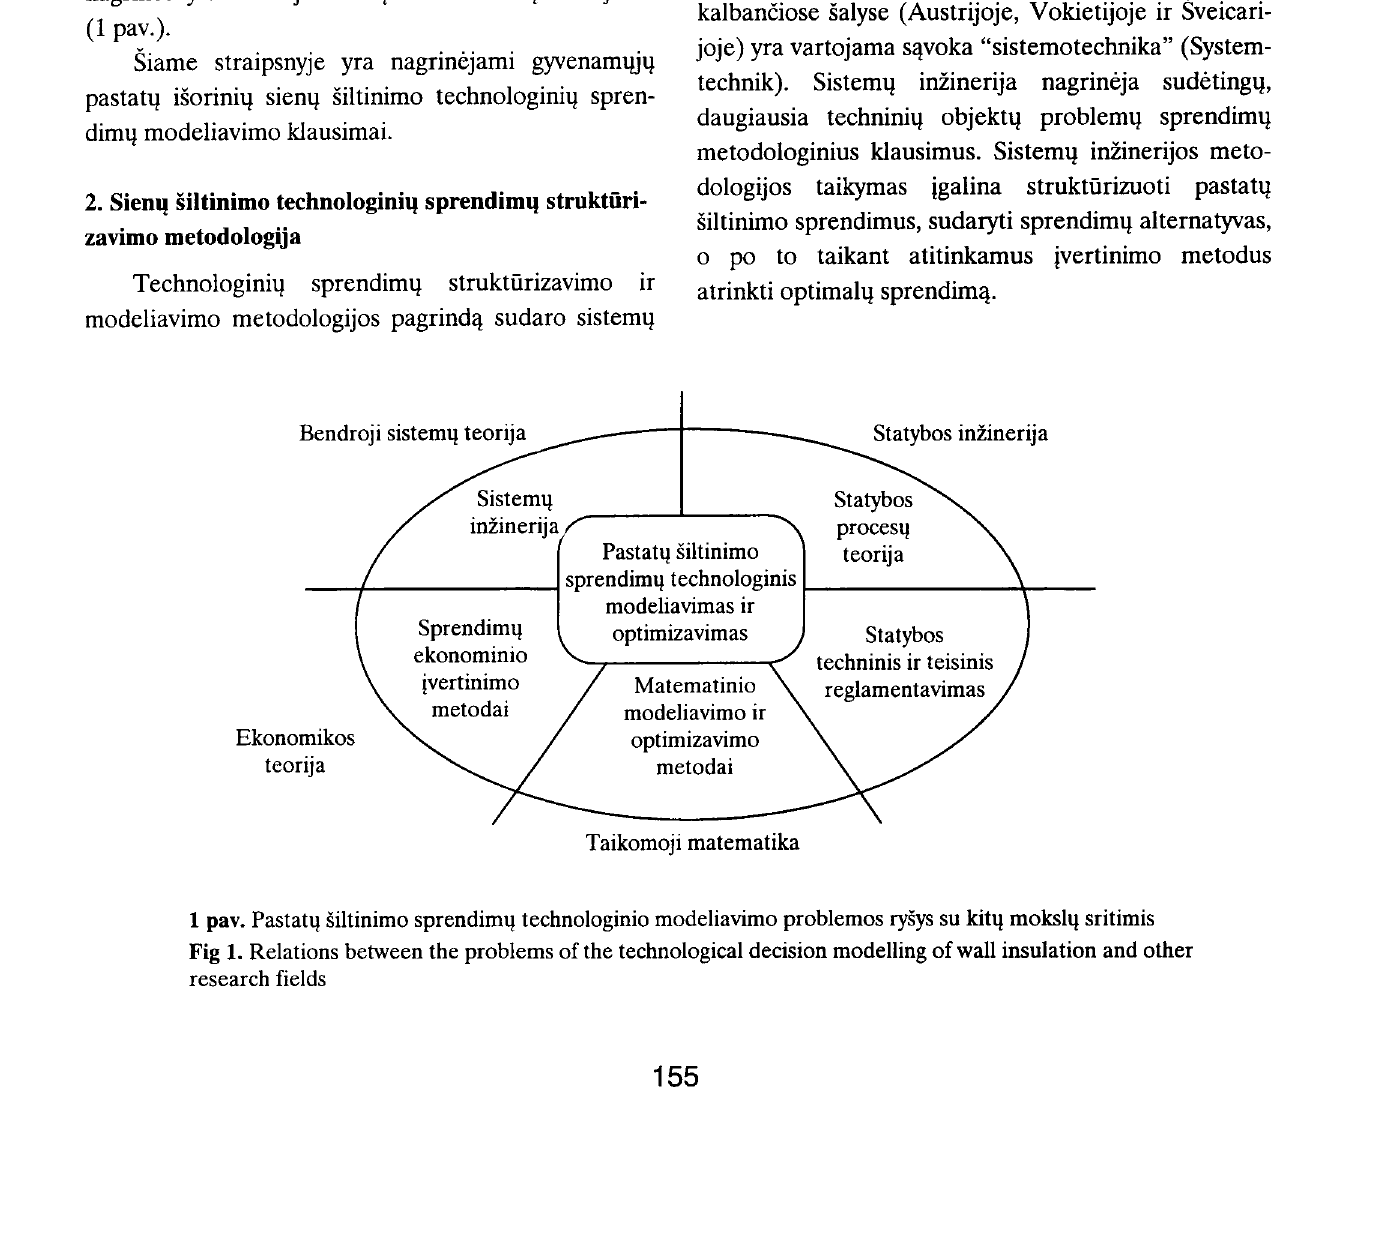
Fig 1. Relations between the problems of the technological decision modelling of wall insulation and other research